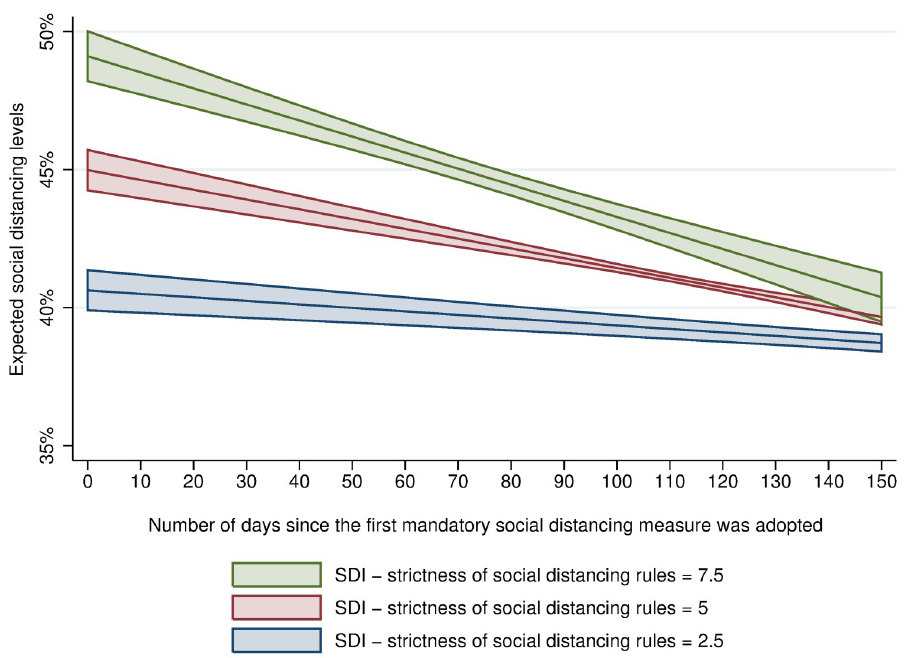
Fig 1. Effect of the duration of mandatory social distancing measures on social distancing levels, by levels of strictness, Brazil (11 th March– 10 th November 2020). Data show the effect of the duration of social distancing rules on social distancing levels conditioned by the strictness of social distancing rules, and controlling for whether wearing a mask was mandatory (as in model 6, R 2 = 0.70). Shading indicates 95% confidence intervals. The distribution of values of the SDI in the dataset was the following: 0 (2.2%); 0.8 (0.7%); 1.7 (6.3%); 2.5 (15.1%); 3.3 (17.6%); 4.2 (13.5%); 5 (14.5%); 5.8 (8.3%); 6.7 (8.9%); 7.5 (8.3%); 8.3 (2.8%); 9.2 (0.7%); 10